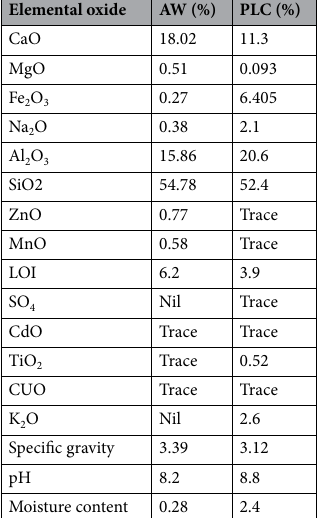
Table 1. Physicochemical properties of cement and aluminum waste (source 24 :).